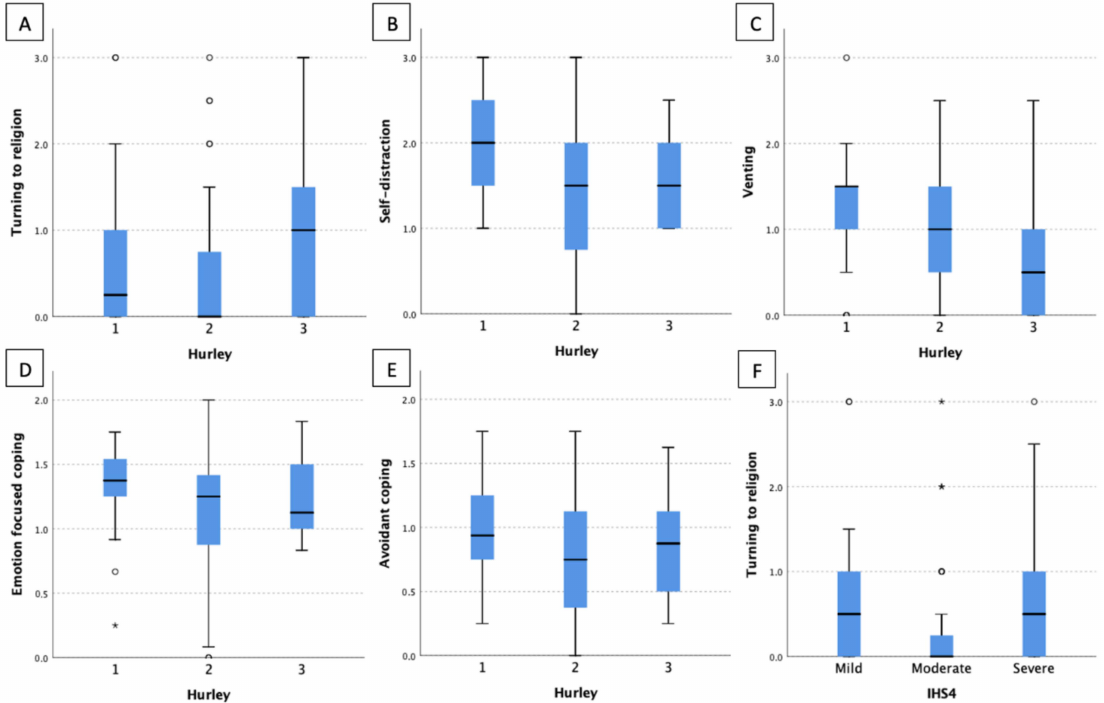
Figure 3. Coping strategies in different HS severity. ( A ) turning to religion/Hurley; ( B ) self- distraction/Hurley; ( C ) venting/Hurley; ( D ) emotion focused coping/Hurley; ( E ) avoidant cop- ing/Hurley; ( F ) turning to religion/IHS4. Each dot represents each patient’s questionnaire score, while asterisks represent outlier